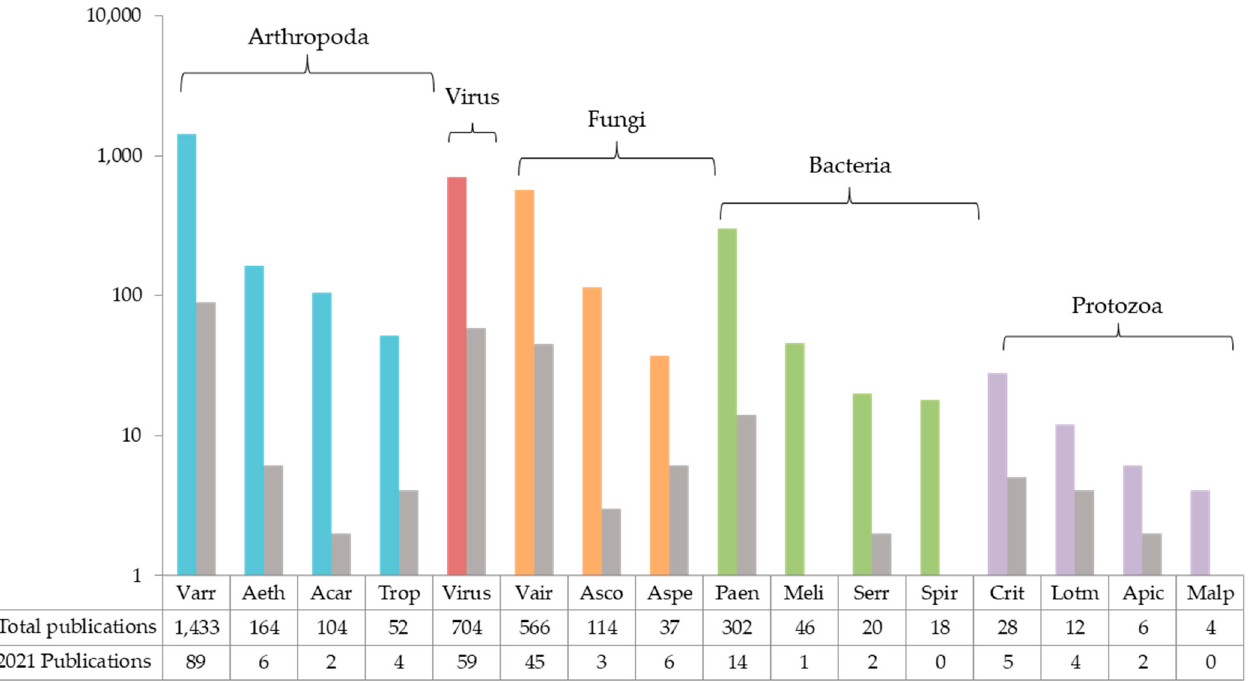
Figure 2. Total number of publications per pathogen type. Measurement of the research activity on bee pathogens, represented by the sum of publications per genus of the main studied organisms that affect A. mellifera . The total number of publications from 1979 to January 2022 and the actual number of publications released in 2021 are shown as an indication of the long-term and actual interest in these pathogens, respectively. Searches were carried out in Scopus ® using “ Apis mellifera ” and, with the exception of viruses, the corresponding genus as keywords, e.g., “ Varroa ”. The number of publications released in 2021 for each pathogen is represented by darker colored columns besides the corresponding column. The genera are grouped by kingdom. Abbreviations: Varroa (Varr) , Aethina (Aeth), Acarapis (Acar), Trophilaelaps (Trop), Nosema (Nose), Ascosphaera (Asco), Aspergillus (Aspe), Paenibacillus (Paen), Melissococcus (Meli), Serratia (Serr), Spiroplasma (Spir), Frishella (Fris), Crithidia (Crit), Lotmaria (Lotm), Apicystis (Apic), Malpighamoeba (Malp). All bee-infecting viruses are considered together. Scale: log 10 . More information can be found in Table S3.